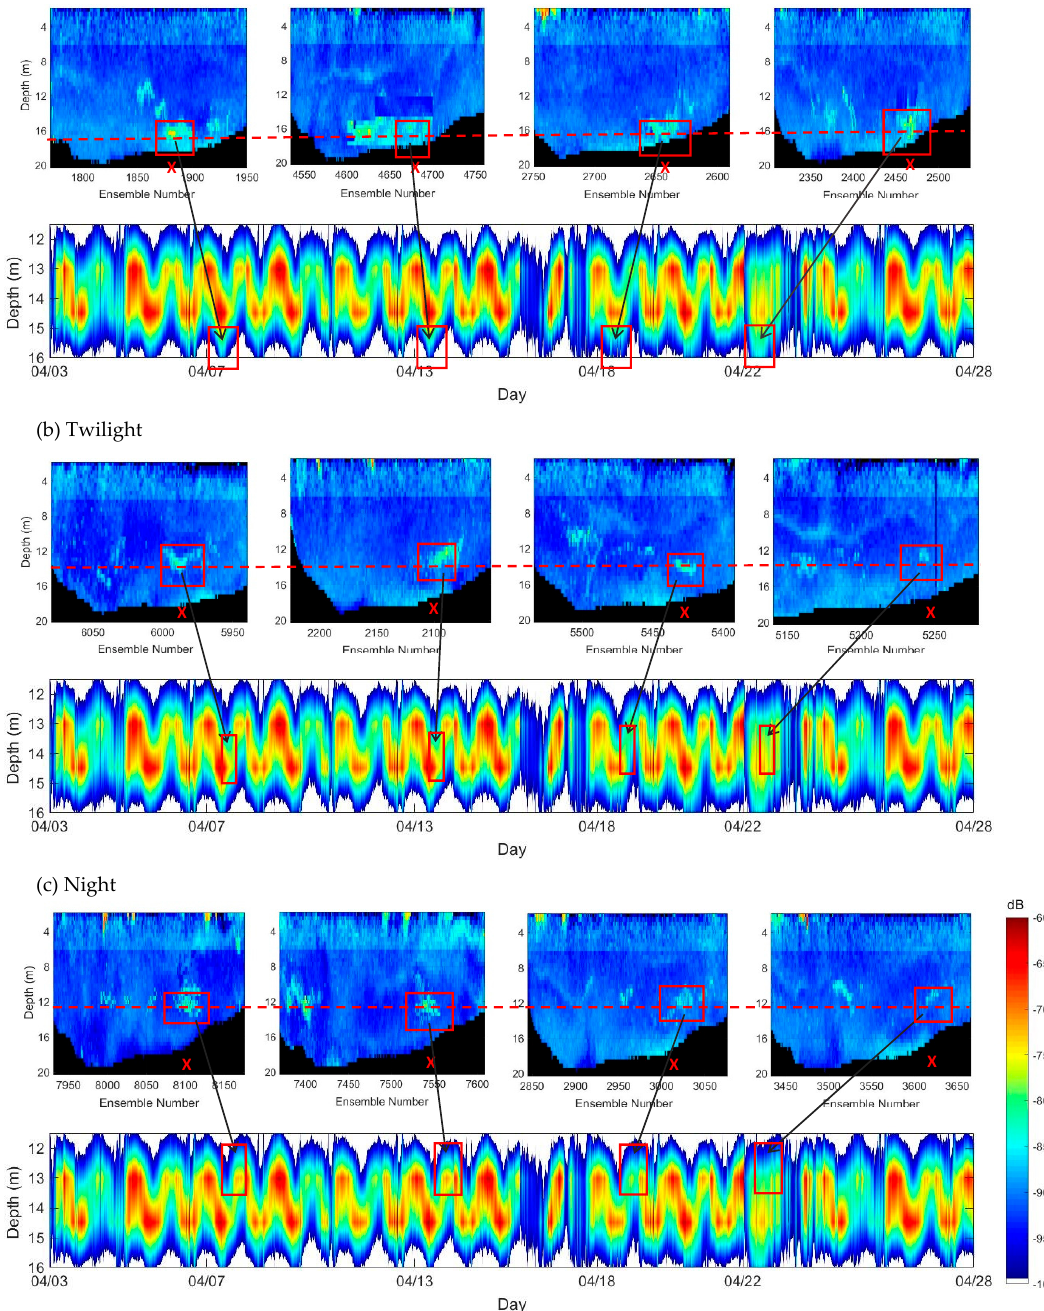
Figure 6. Vertical section of MVBS from mobile (upper) and moored (down) ADCP during ( a ) daylight, ( b ) twilight, ( c ) night time. The dotted red line indicates the position of the zooplankton with red ‘x’ marks visualized the location of moored ADCP. The red square box in both echograms was in the same location and time and are compared further in Figure 8.